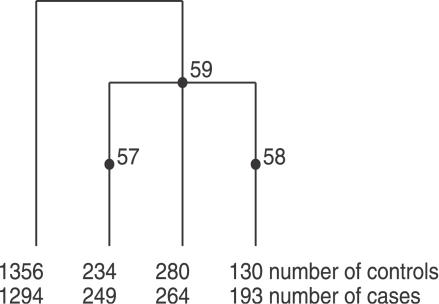
Perfect Phylogeny with the Highest Posterior Probability of Containing the Susceptibility AlleleAt the bottom of each branch we report the case and control multiplicities of each unique haplotype in the tree.